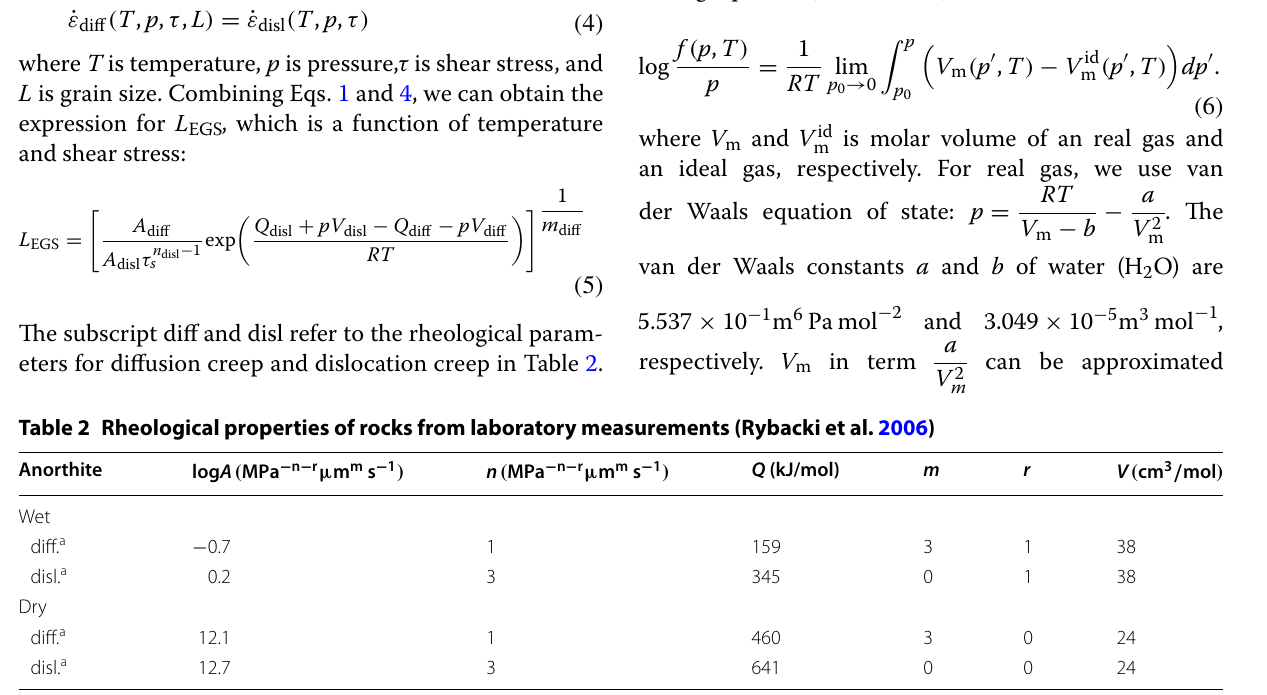
a diff. denotes diffusion creep, and disl. denotes dislocation creep